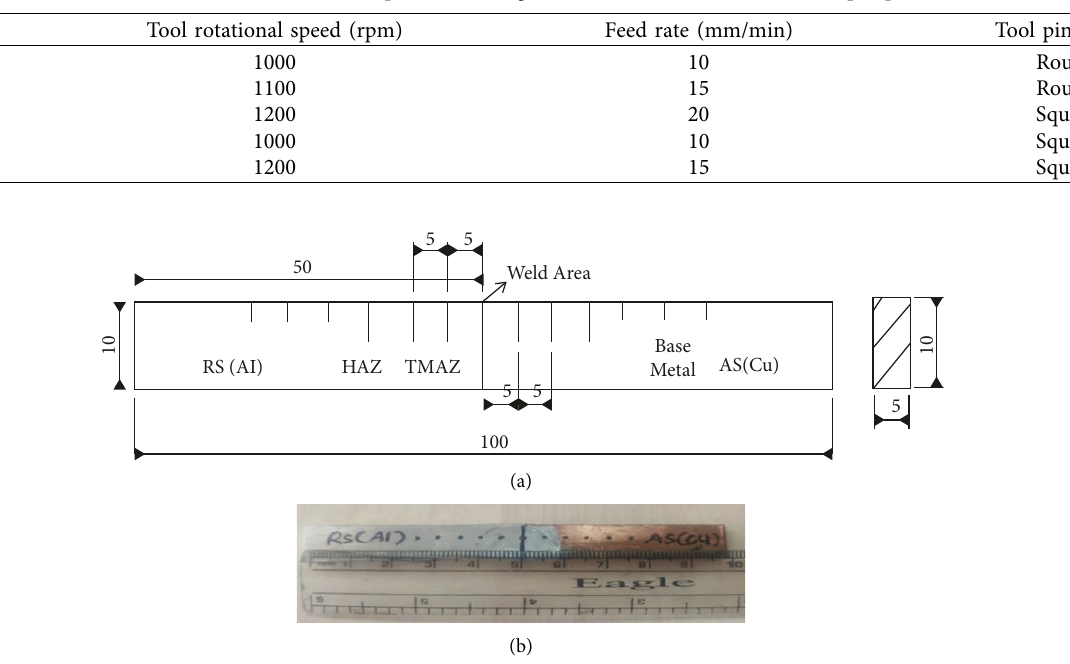
Table 4: Various trials with respective welding tool rotation, feed rates, and tool pin